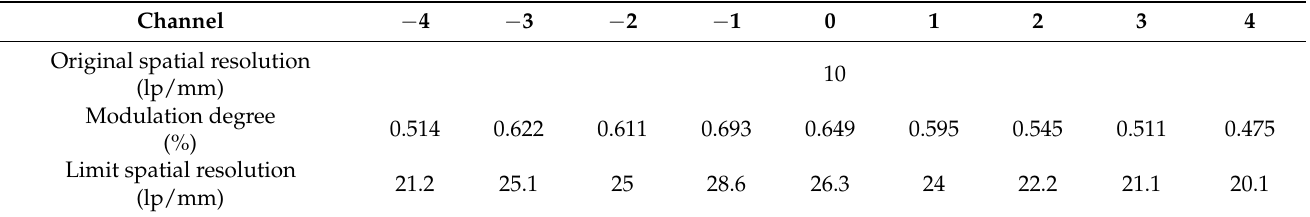
Table 3. The limit spatial resolution of images obtained with the separator powered